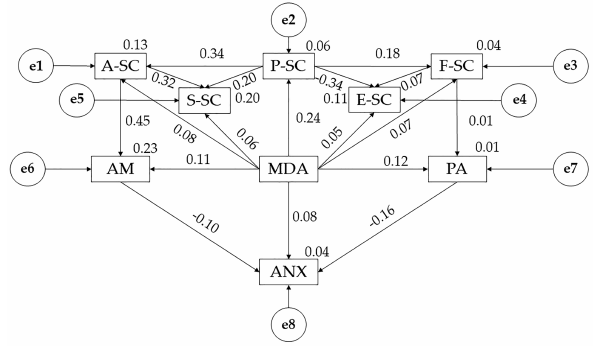
Fig. 2. Theoretical model proposed. A-SC, Academic self-concept; S-SC, Social self-concept; P-SC, Physical self-